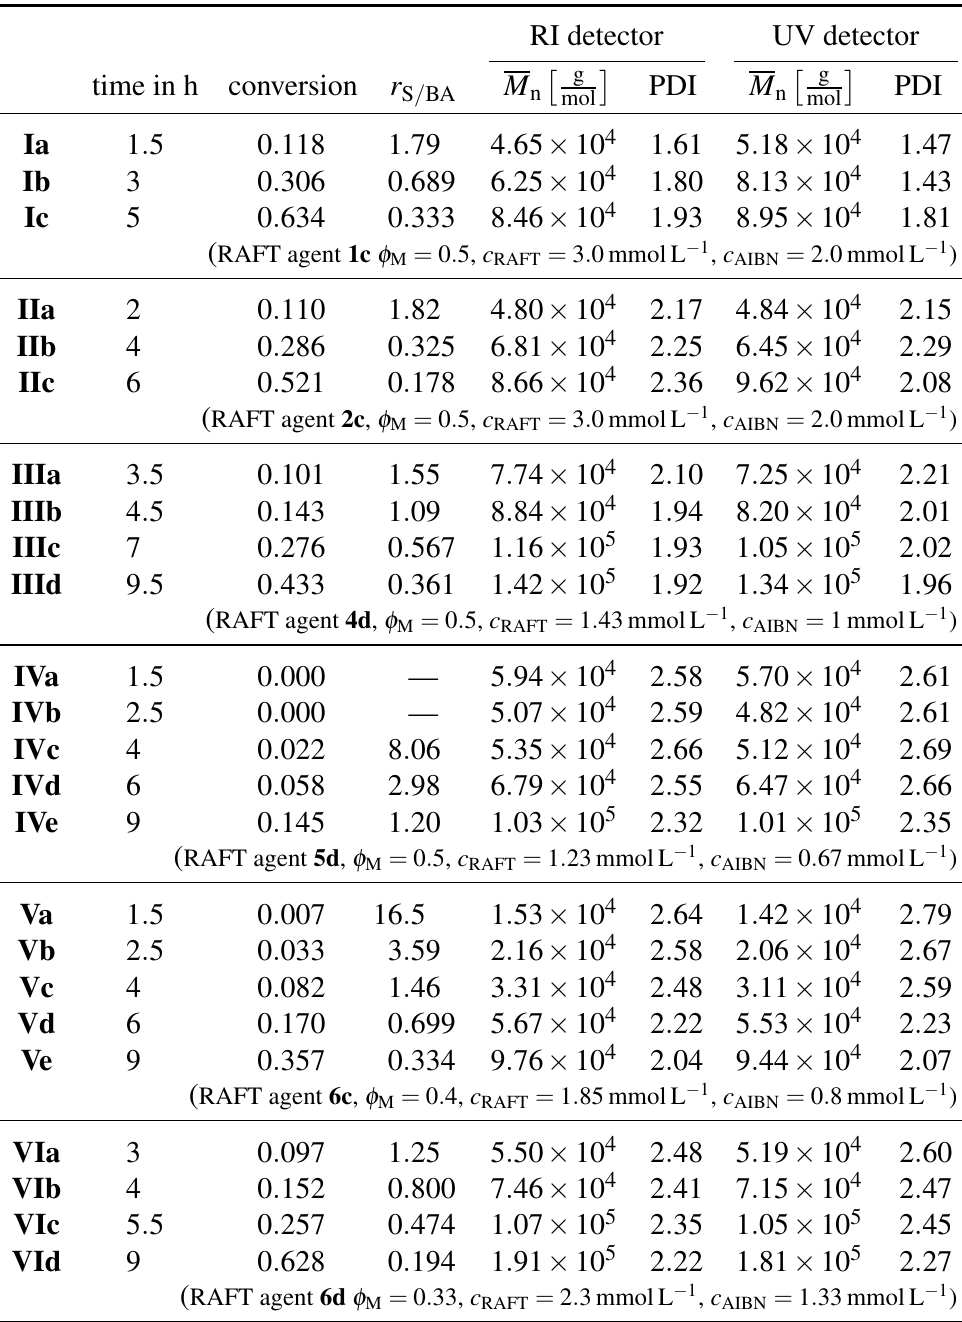
Table 4. Copolymerizations of n -butyl acrylate with different styrene macroRAFT agents in solution of toluene at 60 ◦ C and ambient pressure using AIBN as initiator. The table lists the individual experimental conditions, the gravimetrically determined monomer conversions of the samples, and the corresponding M and polydispersity indices (PDI) obtained by the RI n and the UV detector. φ is the volume fraction of the monomer in the polymerization mixture, M r is the gravimetrically determined mass ratio of styrene and BA in the polymers. SEC S / BA data were obtained with calibration for pure linear